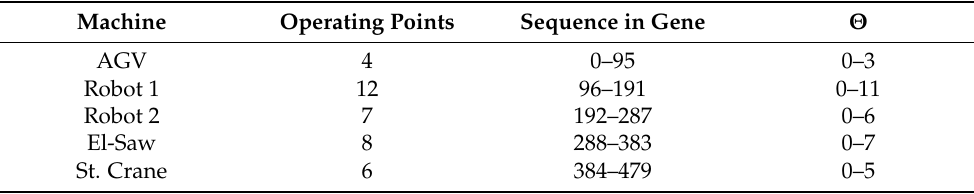
Table 2. Parameters of the Real Value Coding